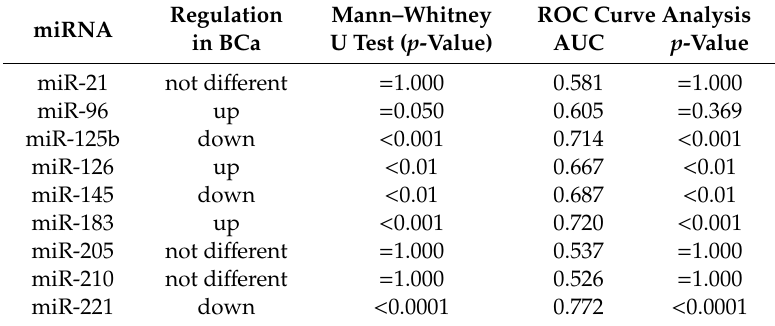
Table 3. Comparison of the relative miRNA expression levels in urine sediments from the BCa and control groups (Mann–Whitney U test) and assessment of the diagnostic power by ROC curve analyses. All p-values were adjusted by Bonferroni’s correction for multiple comparisons.